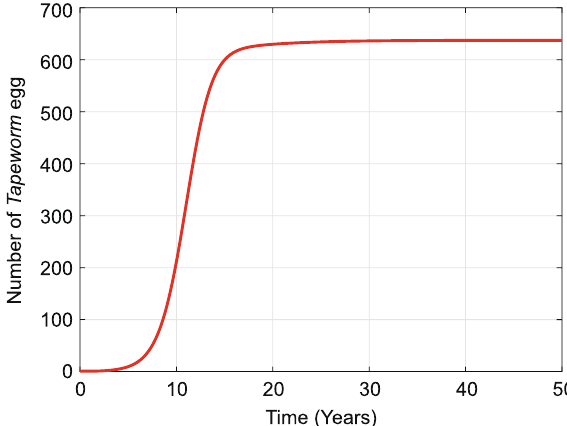
Fig. 4 Variation of Taenia solium egg number with time